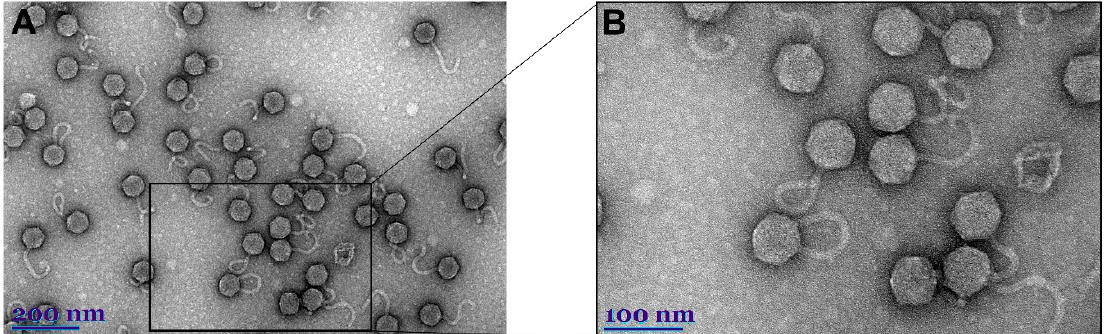
Figure 1. Electron micrographs of vB_PagS_AAS23 virions.